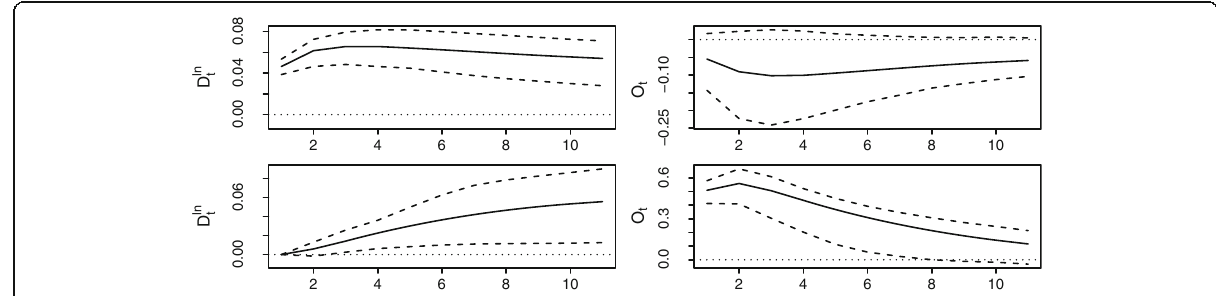
Fig. 6 Orthogonal impulse response functions with 95% bootstrap CI for all phases. Top: from D ln and O t